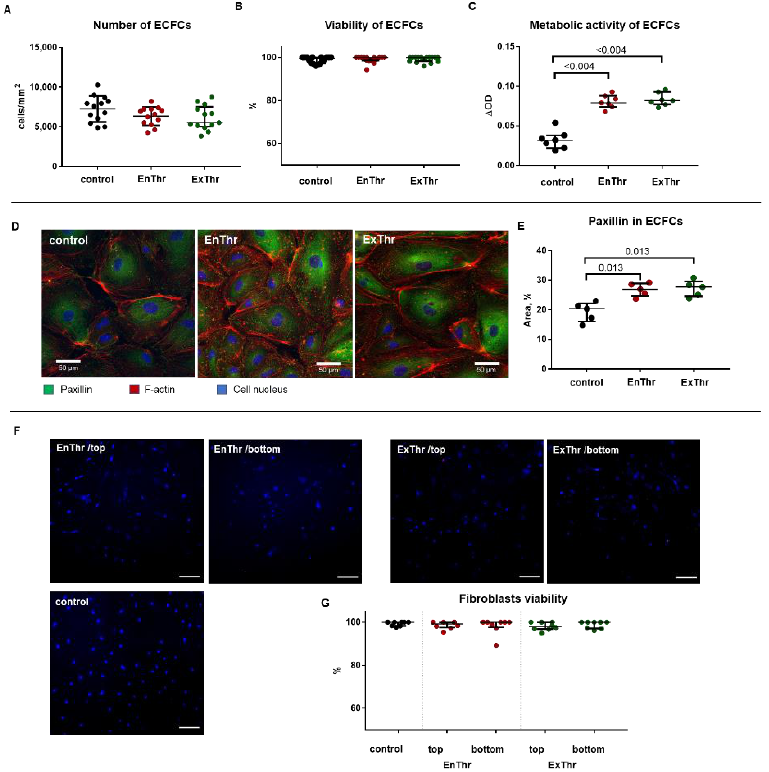
Figure 5. Biological properties of fibrin matrices prepared using endogenous (EnThr) and exogenous (ExThr) thrombin: ( A ) number of the endothelial cells on the fibrin surface; ( B ) viability and ( C ) metabolic activity of the endothelial colony forming cells (ECFCs); ( D ) immunofluorescent staining of focal adhesions in endothelial cell (paxillin-green, F-actin–red, cell nucleus-blue), scale bar 50 µ m, × 400 magnification; ( E ) quantitative analysis of paxillin; ( F ) fluorescent analysis of fibroblast viability on the top and bottom sides of the fibrin matrices (dead cells–red, cell nucleus–blue), scale bar 100 µ m, × 100 magnification; ( G ) quantitative analysis of fibroblast viability. Center lines indicate the median, whiskers indicate the 25th and 75th